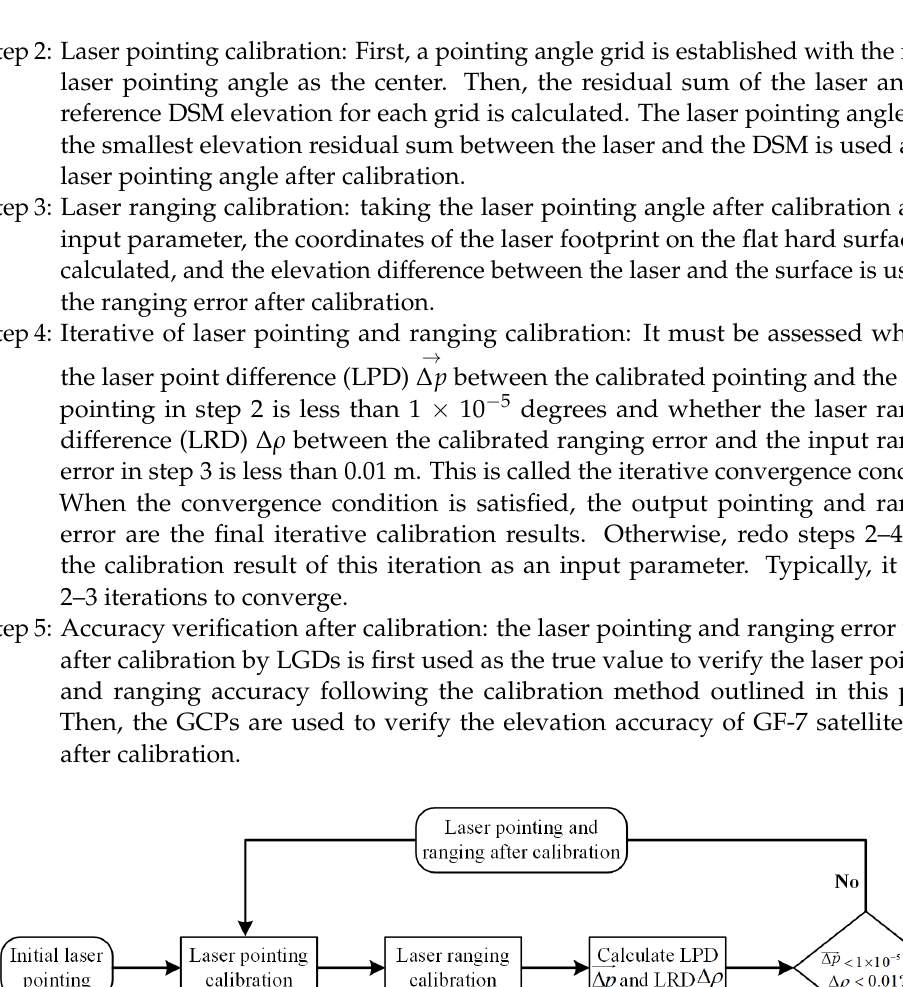
Figure 5. Flow chart of the proposed satellite laser calibration method without a field detector in the study .